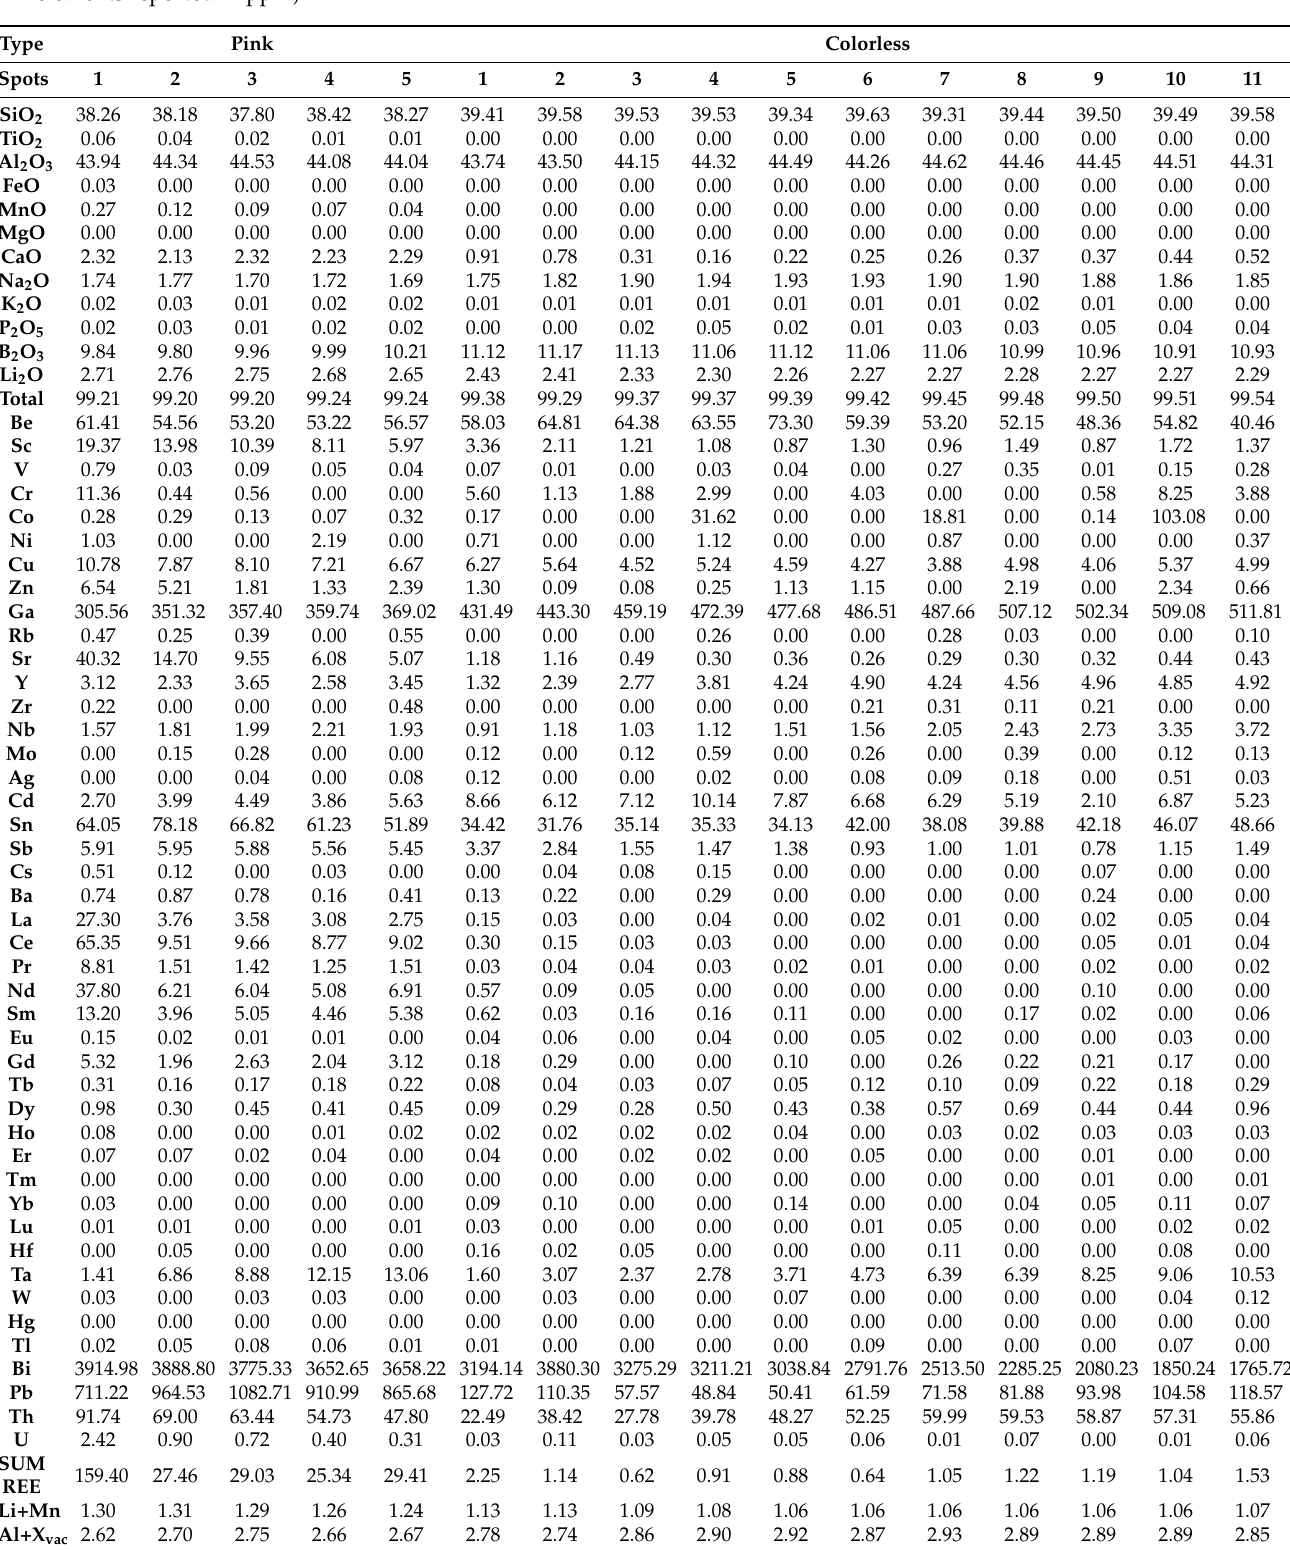
Table 2. LA-ICP-MS data of tourmaline from the pink part to the colourless part (major elements reported in wt% and trace elements reported in